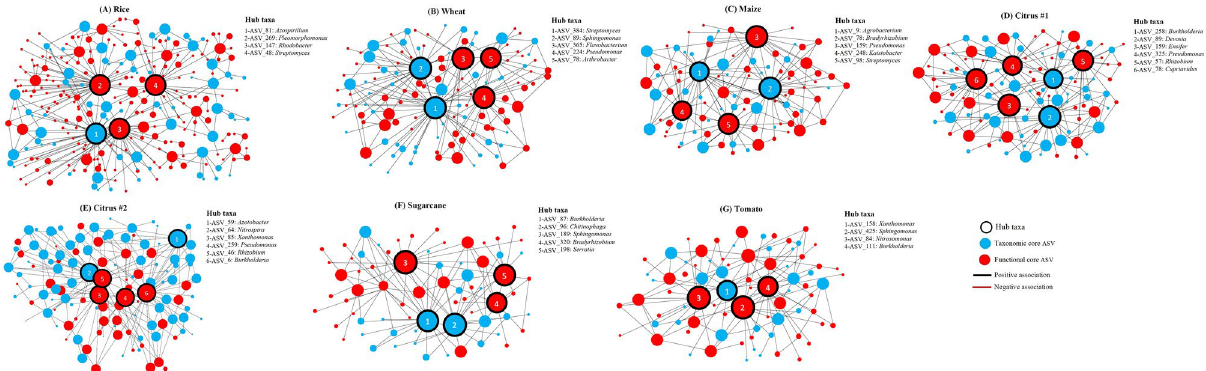
Figure 4. Co-occurrence networks showing significant associations between taxonomic and functional core OTUs belonging to the taxonomic and functional core rhizobiomes, respectively for rice ( A ), wheat ( B ), maize ( C ), citrus #1 ( D ), citrus #2 ( E ), sugarcane ( F ), and tomato ( G ). Node size reflects the node degree (number of neighbours/correlations in the network). Hub taxa are listed and highlighted with black borders in the networks and were identified as per Fig. S4. The full taxonomic affiliation of the hub taxa is presented in Table S6. Network visualization was performed using Cytoscape v3.7.1.